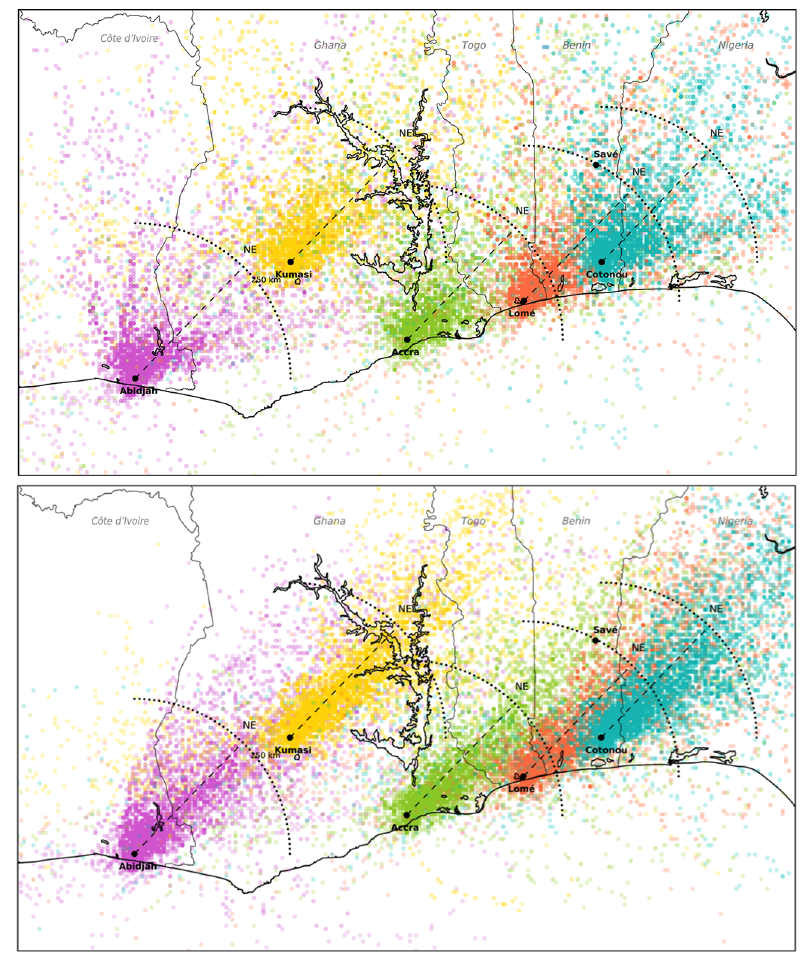
Figure 19. Pollution plumes for the five main cities of interest during DACCIWA (Abidjan, Kumasi, Accra, Lomé, Cotonou) during Phase 1 (top, 1–21 June 2016) and Phase 2 (bottom, 22 June–20 July 2016). Shown are results from daily 24h simulations using the FLEXPART model (see Sect. 2.2). Each dot is coloured according to its city source with the opacity increasing with the occurrences of pollution tracers at each point location. The quarter circles show distances of 250km around the main dispersion direction towards the northeast (dashed